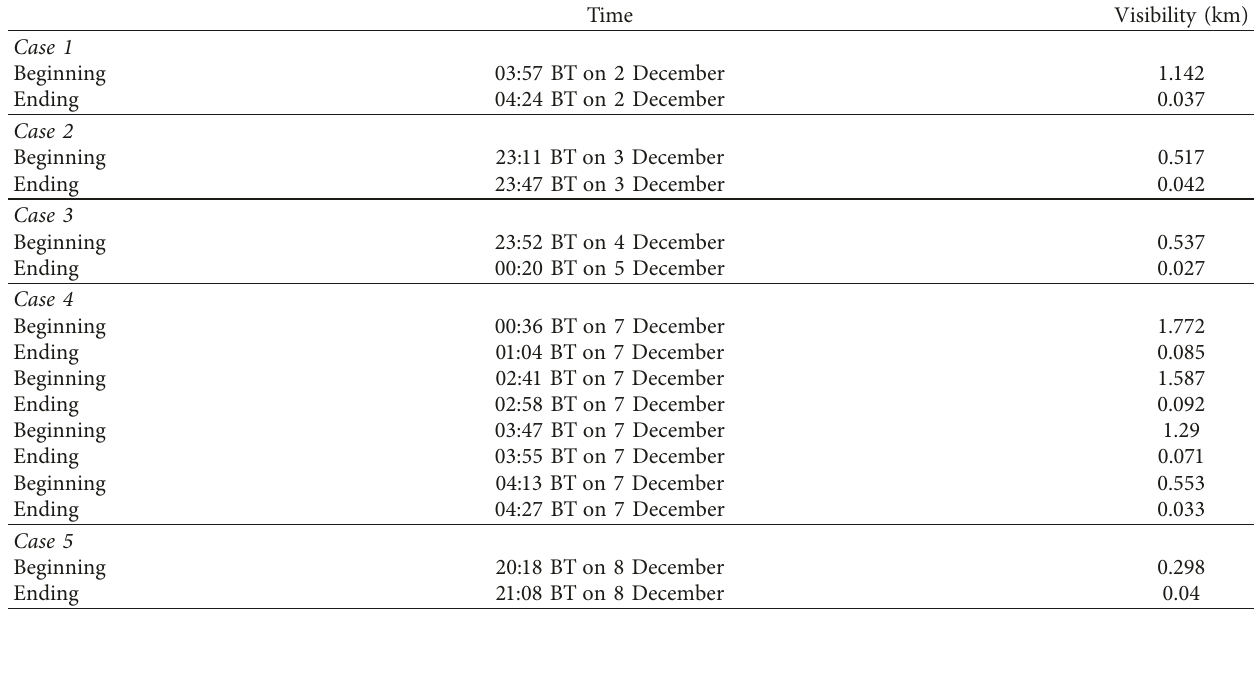
Table 1: The beginning and ending times of five explosive processes and the visibility at each time.